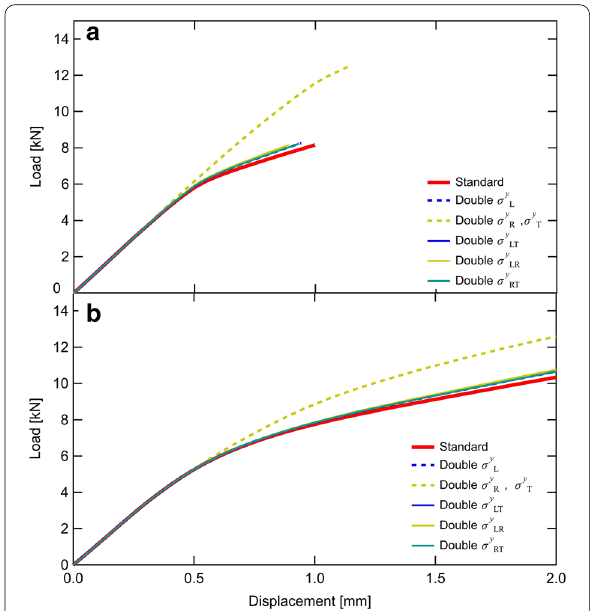
Fig. 8 Embedment load–displacement curve obtained via FEA with intentionally changed material constants in ( a ) S40T6 and ( b ) S80T2.3